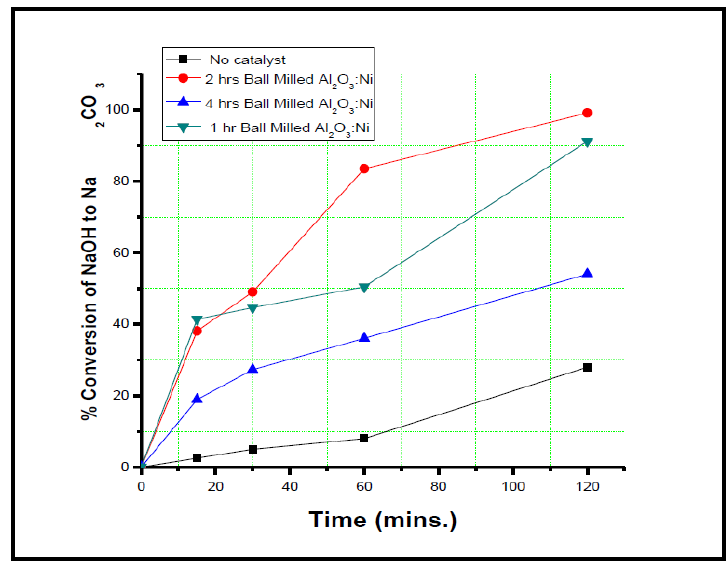
Figure 5. % Conversion of NaOH to Na (wt.%) at 300 °C. 2 h ball milling time has exhibited the best result.